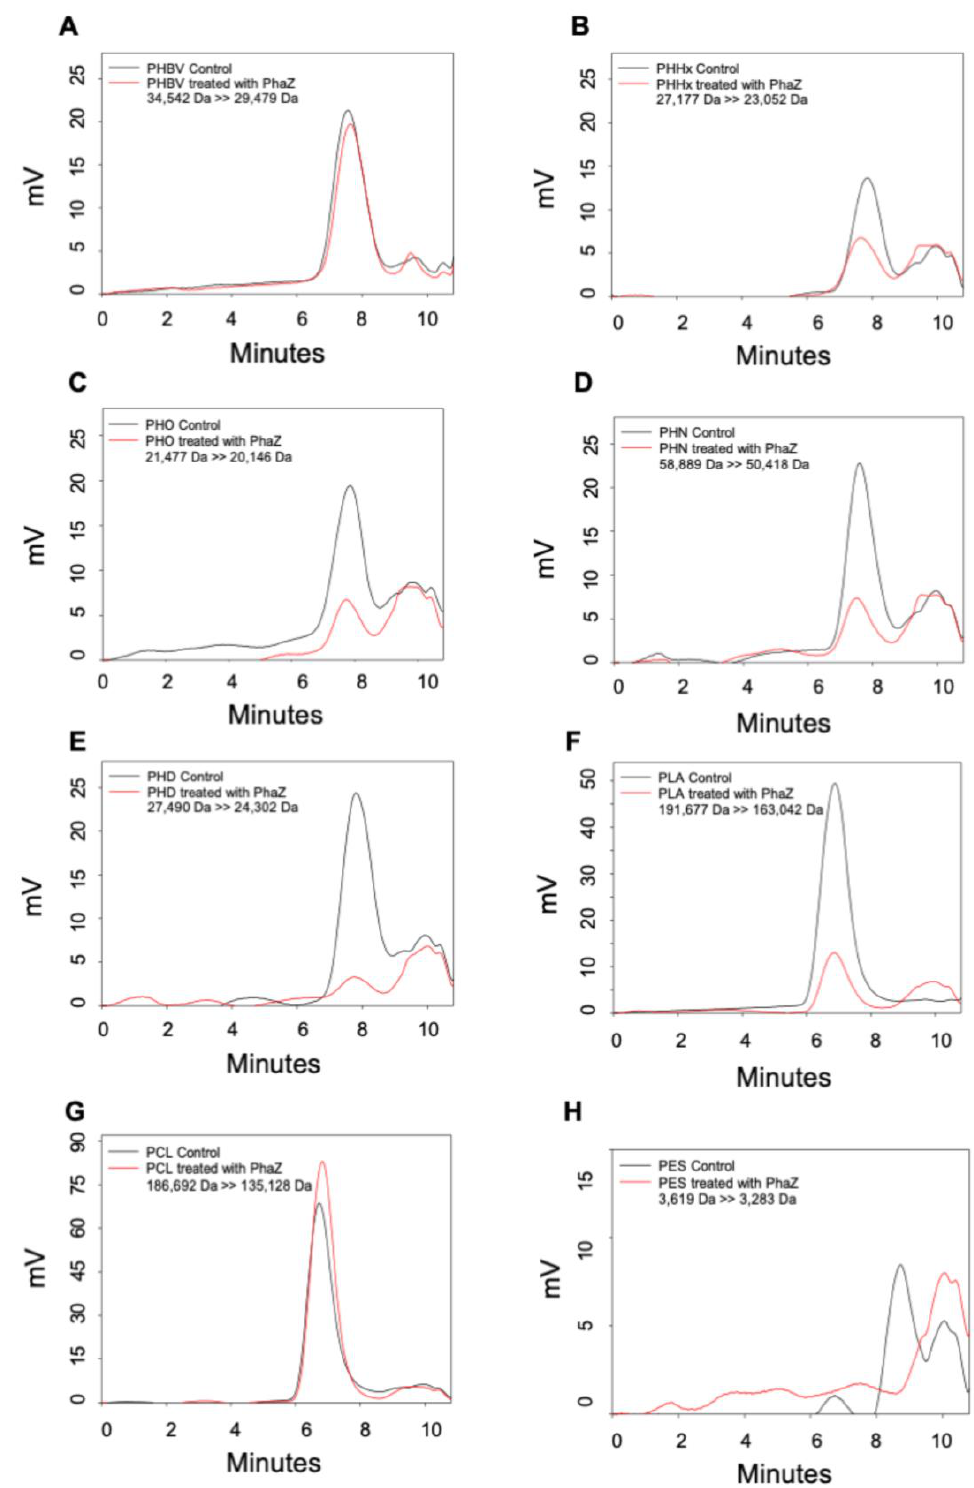
Figure 10. Gel Permeation Chromatography (GPC) analyses of PhaZ. The overlay of chromatograms of different polymer substrates before (control = black line) and after PhaZ treatment (red line). ( A ) PHBV; ( B ) PHHx; ( C ) PHO; ( D ) PHN; ( E ) PHD; ( F ) PLA; ( G ) PCL; and ( H ) PES. Numbers indicate the change in polymer molecular weight before and after treatment. mV, the HPLC Refractive Index Detector records the signa intensity in millivolts.